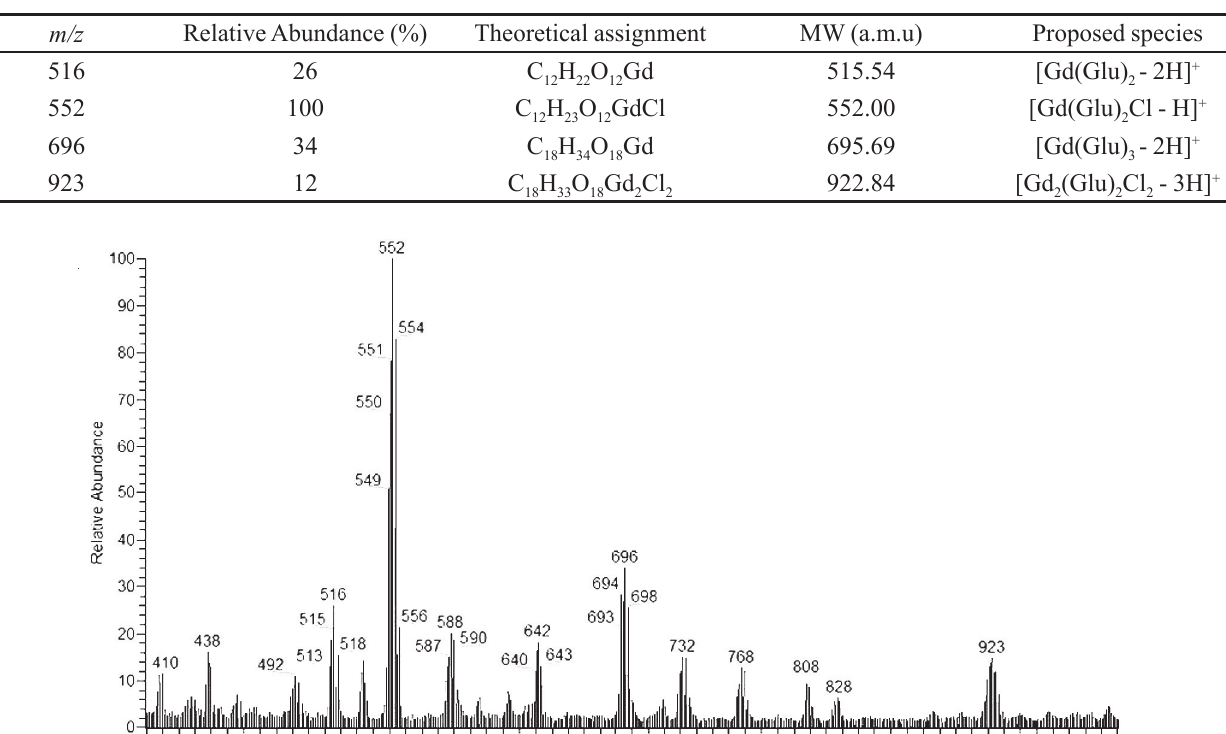
TABLE II – Attributions of the m/z signals in the spectrum of the Gd-Glu solution, the relative abundance in ESI-MS, the specification of theoretical assignment of the chemical formula, nominal mass (a.m.u) estimation and possible ion species in the complex